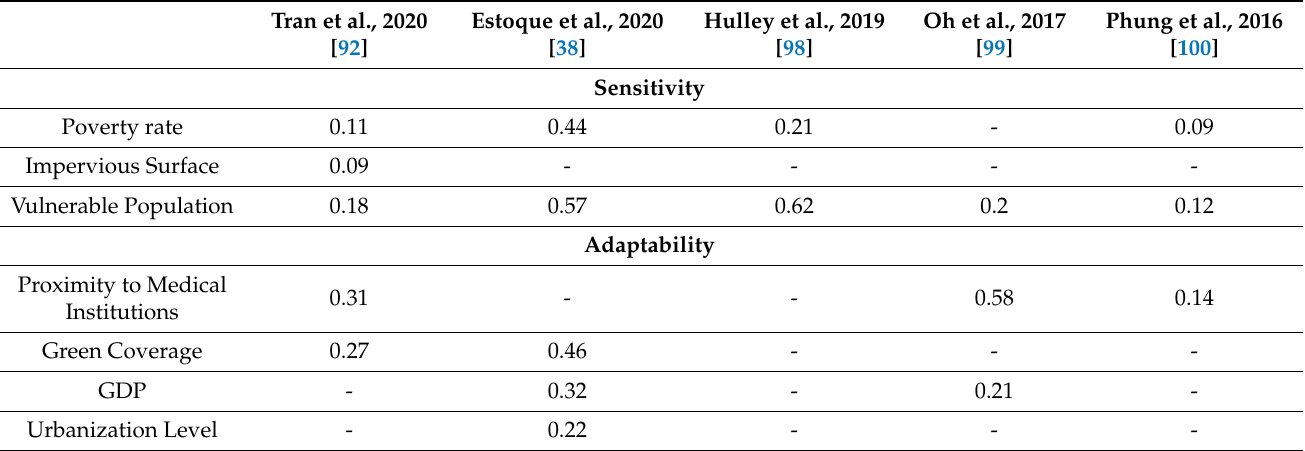
Table 3. The weight of indicators in similar studies.